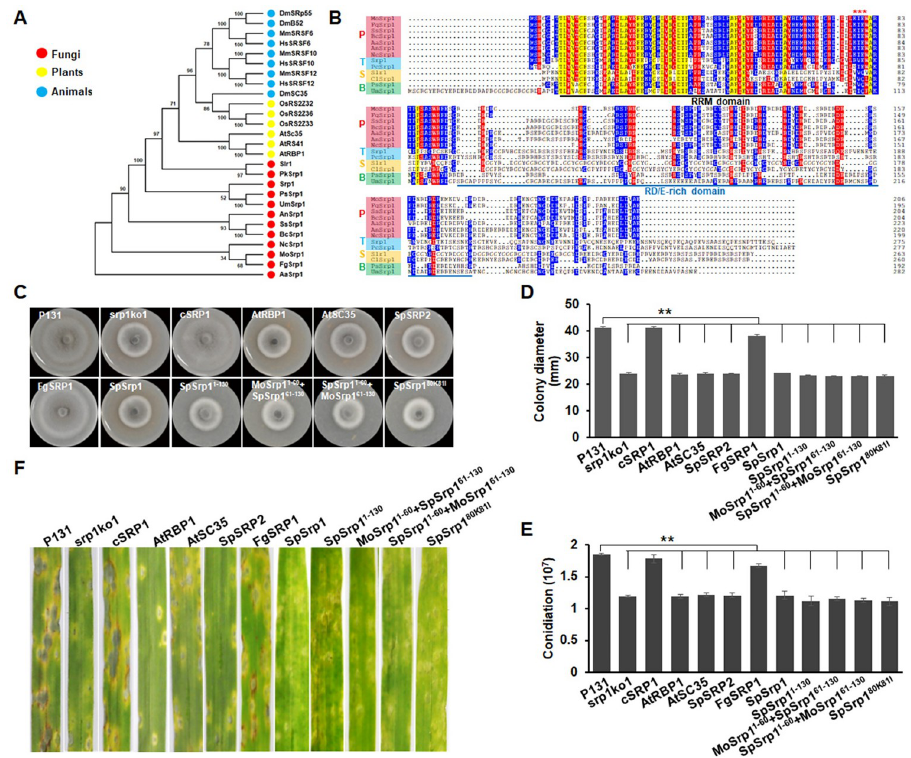
Fig 11. MoSrp1 homologues in Pezizomycotina fungi are functionally similar but divergent from those in other eukaryotes. (A) Phylogenetic analysis of MoSrp1 and its orthologues from different fungi (red dot): Fusarium graminearum (FgSrp1), Sclerotinia sclerotiorum (SsSrp1), Botrytis cinerea (BcSrp1), Alternaria alternata (AaSrp1), Aspergillus nidulans (AnSrp1), Neurospora crassa (NcSrp1), Puccinia striformis (PsSrp1), Ustilago maydis (UmSrp1), Schizosaccharomyces pombe (Srp1), Pneumocystis carinii (PcSrp1), and Candida albicans (Slr1), plants (yellow dot): Arabidopsis thaliana (AtSc35, AtRS41, and AtRBP1) and Oryza sativa (OsRS2Z32, OsRS2Z33, and OsRS2Z36), animals (blue dot): Drosophila melanogaster (DmSC35, DmSRp55, and DmB52) and Mus musculus (MmSRSF6, MmSRSF10, and MmSRSF12), and human Homo sapiens (HsSRSF6, HsSRSF10, and HsSRSF12). (B) Sequence alignment of MoSrp1 and its counterparts from other fungi including Pezizomycotina (P) FgSrp1, SsSrp1, BcSrp1, AaSrp1, AnSrp1, and NcSrp1, Taphrinamycotina (T) Srp1 and PcSrp1, Saccharomycotina (S) Slr1 and ClSrp1, and Basidiomycota (B) PsSrp1 and UmSrp1. The conserved amino acids among different fungi were highlighted. The RRM domain and RD/E-rich domain of MoSrp1 were underlined. An asterisk marks the SUMOylation site . (C) Colonies formed on OTA plates at 6 dpi by the strains P131, srp1ko1, cSRP1 and srp1ko1 transformants expressing AtRBP1 ( AtRBP1 /srp1ko1), AtSC35 ( AtSC35 /srp1ko1), SpSrp2 ( SpSrp2 /srp1ko1), SpSrp1 ( SpSrp1 /srp1ko1), FgSrp 1 ( FgSrp1 / srp1ko1), the MoSrp1-SpSrp1 chimeric structures: SpSrp1 1-130 (the N terminal 130 aa residues of SpSrp1), MoSrp1 1-60 - SpSrp1 61-130 (the N terminal 60 aa residues of MoSrp1 fused with the 61–130 aa residues of SpSrp1), SpSrp1 1-60 - MoSrp1 61-130 (the N terminal 60 aa residues of SpSrp1 fused with the 61–130 aa residues of MoSrp1), and SpSrp1 80K/81I (SpSrp1 mutated with the sumoylation site). (D) Statistics on colony growth of the strains described in (C). (E) Statistics on conidiation of the strains described in (C). The means and standard deviations in (D-E) were calculated based on three independent experiments by measuring three plates for each replicate. Asterisk marks significant difference between P131 and mutant strains using t -test (p < 0.05). (F) Representative disease lesions on the leaves of susceptible barley sprayed with conidia of the strains described in (C). To further delimit which regions of MoSrp1 result in the function diversification, we gener- ated mosaic constructs of MoSrp1 with SpSrp1, and individually introduced them into srp1ko1 (S9 Fig). The SpSrp1 1-130 , MoSrp1 1-60 -SpSrp1 61-130 , and SpSrp1 1-60 -MoSrp1 61-130 alleles failed to rescue defects of srp1ko1 on colony growth, conidiation, and plant infection (Fig 11C–11F). In addition, SpSrp1 80K81I , a mutated construct generated to possess the same sumoylation site at the 80th aa as MoSrp1 also failed to rescue srp1ko1 (Fig 11C–11F).